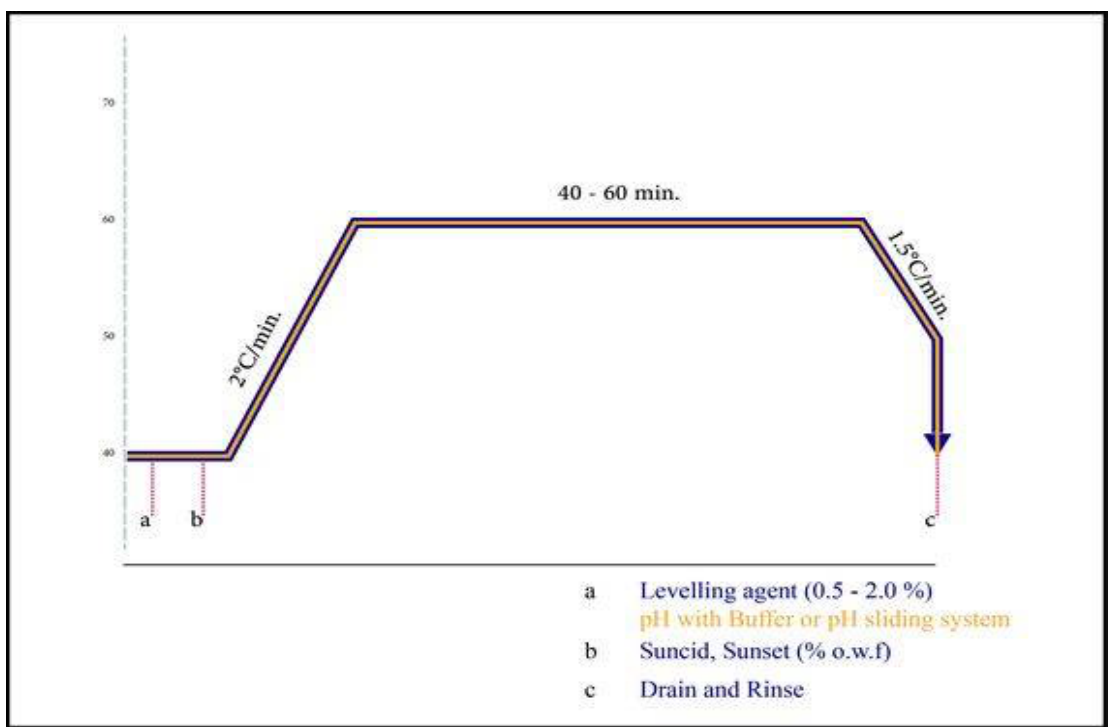
Figure 2. Processing dyeing curve of the two commercial acid dyes used: A: Levelling agent, 0.5–2.0%, PH with Buffer or PH sliding system; B: Dye; C: Drain and